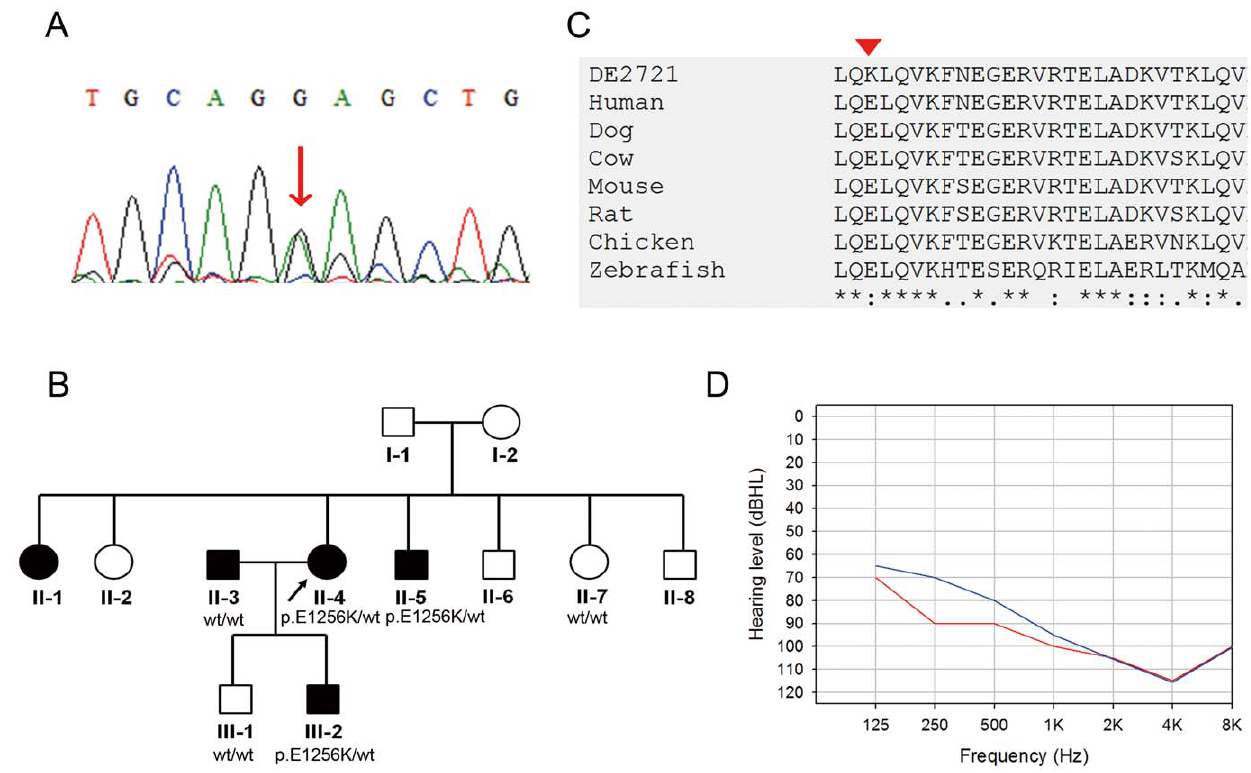
Figure 4. The MYH9 p.E1256K variant identified in Family DE2721. (A) Sanger sequence of the MYH9 p.E1256K variant. Arrow: nucleotide change c.3766G . A (p.E1256K) variant. (B) Pedigree and segregation pattern of Family DE2721. (C) Evolutionary conservation of the p.E1256 residue. Arrowhead: variant site. (D) Audiogram of the proband of Family DE2721. Hearing levels of the right ear and left ear are marked with red and blue lines,